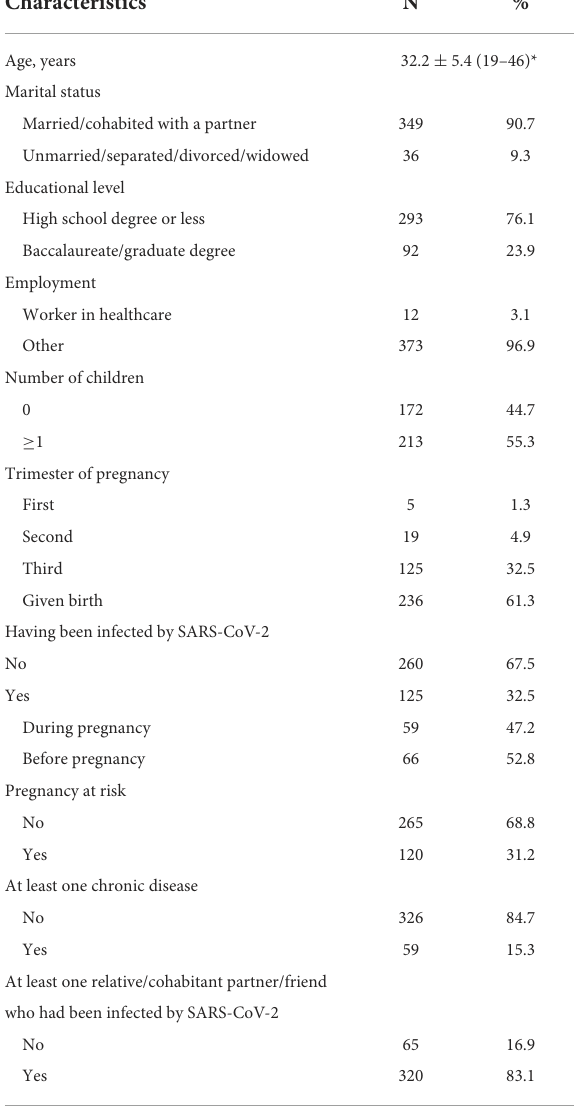
TABLE 1 Socio-demographic and key characteristics of the study